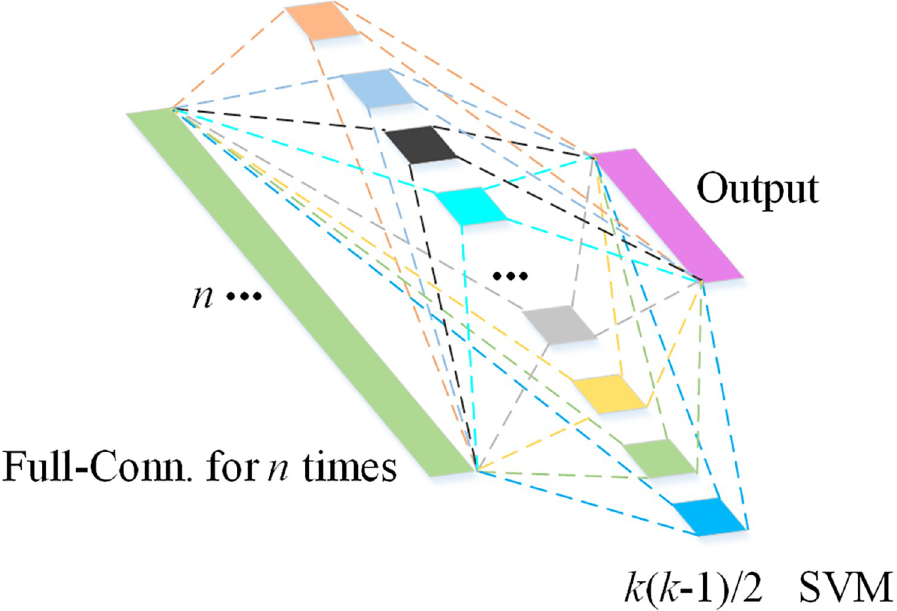
Fig 7. Illustration the multi-class SVM model starting from pairwise classification to the final